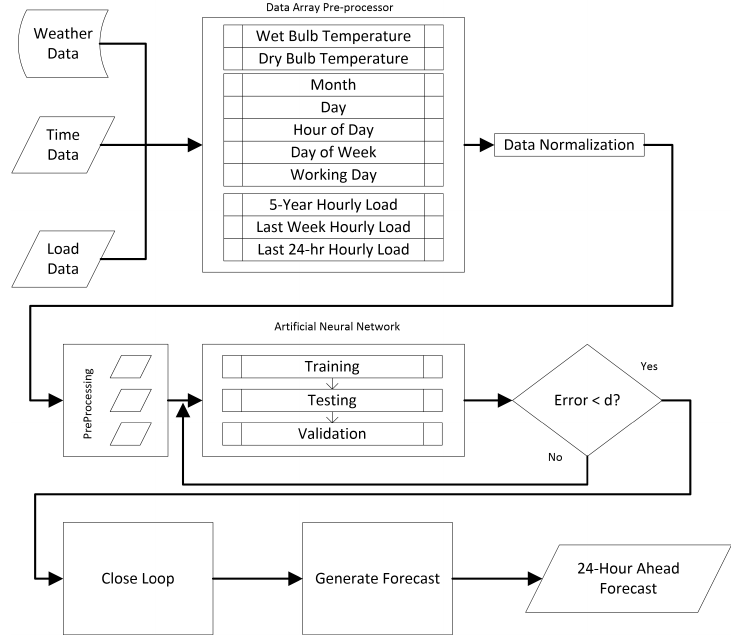
Figure 2. Proposed flowchart.